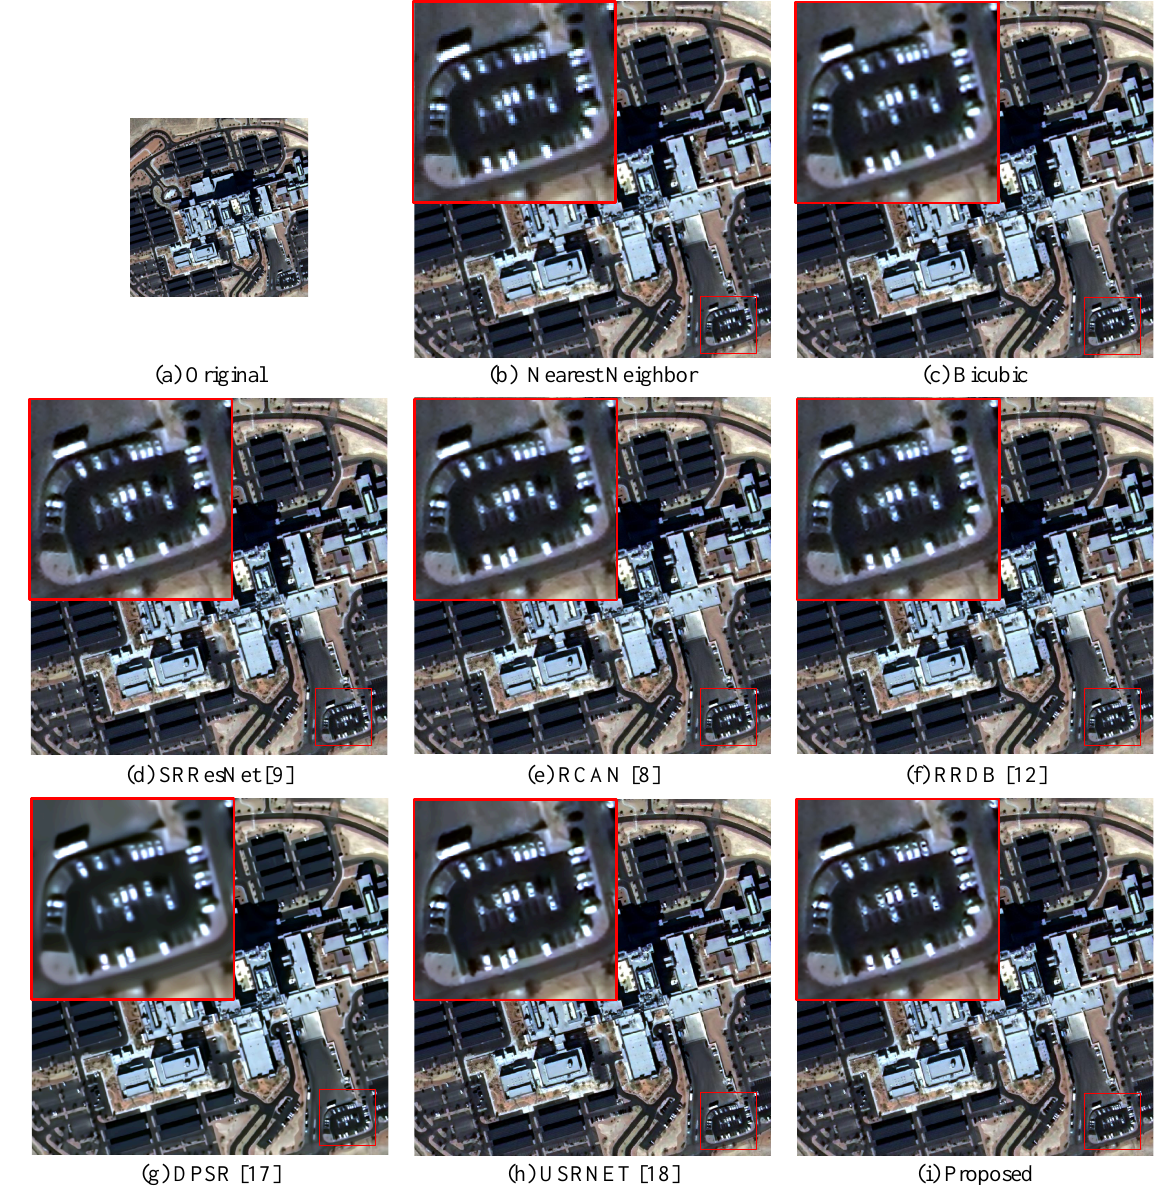
Figure 10. Visual qualitative comparisons of the proposed method with other SR methods on an pansharpened KOMPSAT-3 image, VA Southern Nevada Healthcare System,